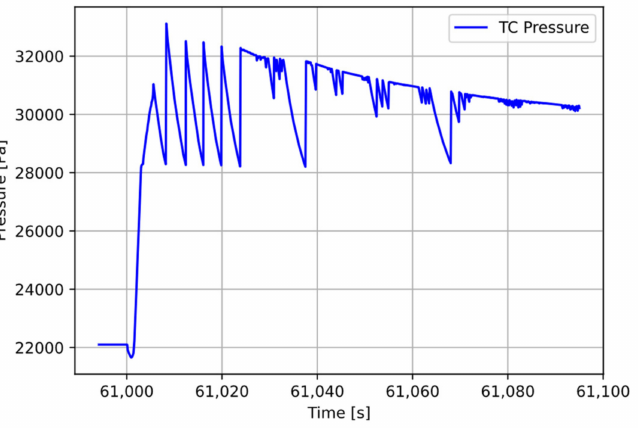
Figure 8. Pressurization of TC after PIE. Figure 9 focuses on the temperatures on the liner floor and related cooling systems. Leaked lithium is released at a temperature of 546 K and then quickly cools down once in contact with the liner floor. In turn, the liner floor quickly passes from the 287 K temperature before PIE, to 463 K within 50 s, peaking at 472 K within 220 s. As a consequence, the underlying cooling pipe HS and water coolant reach 460 K.